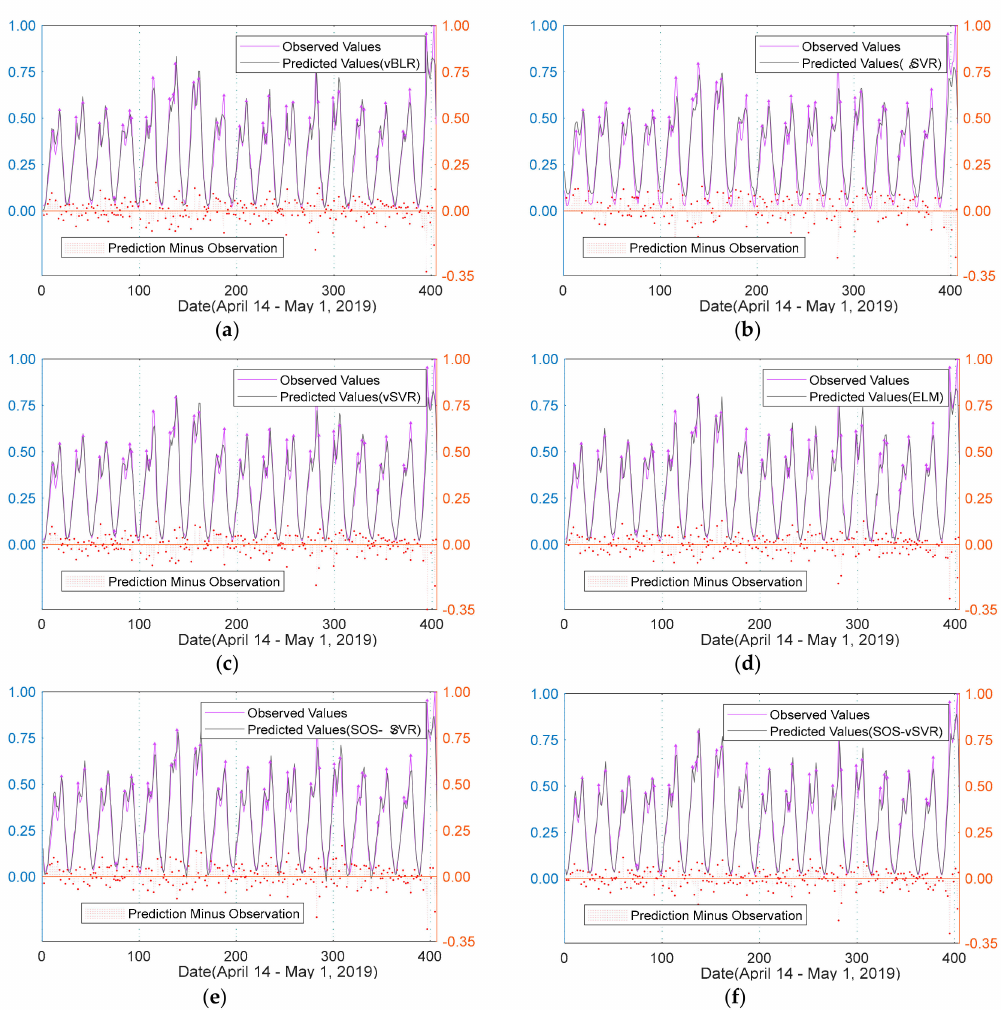
Figure 7. Comparison of predicted and observed values of each regression model on the test